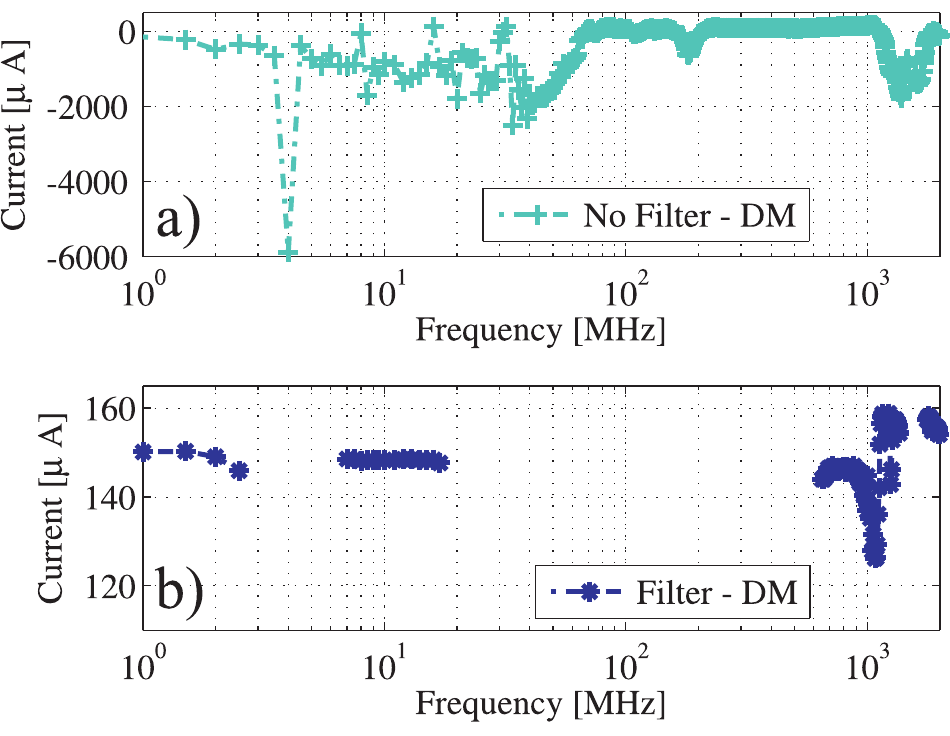
Figure 8. DC current absorbed from the battery pack by the BMS IC cell inputs in accordance with DPI failures levels in Figure 4 for DM injection performed on the 6th, without ( a ) and with ( b ) the RC